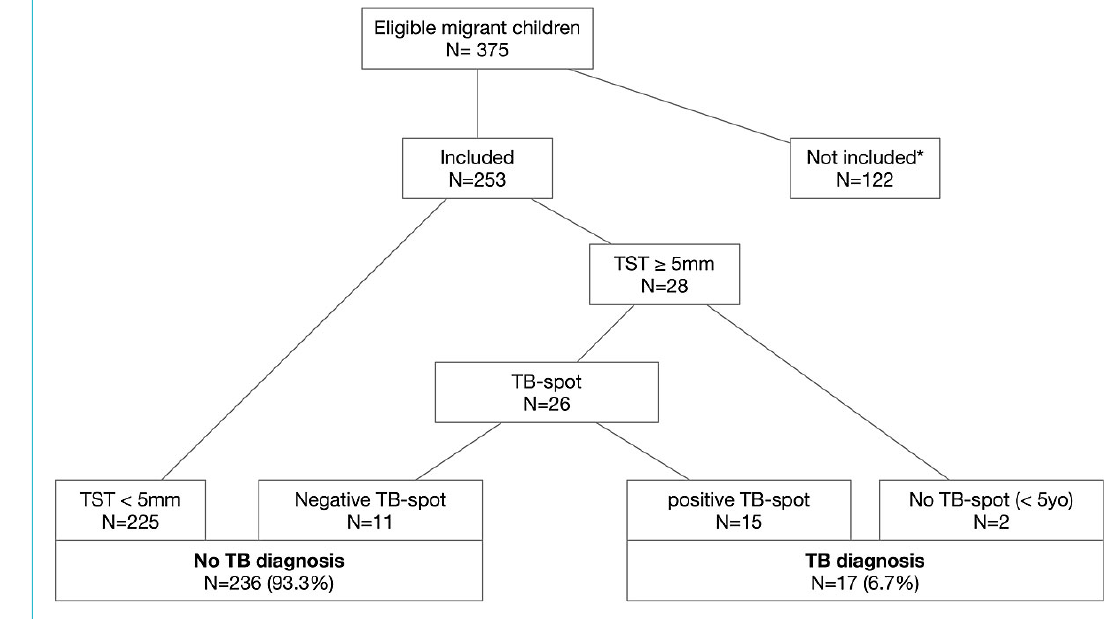
Figure 1: Description of the population. TB = tuberculosis; TBD = tuberculosis disease; TST = tuberculin skin test; * no TB screening (n = 16), parental refusal (n = 4), tuberculosis disease diagnosed before the assessment (n = 3), oblivion/lack of time (n = 87), lack of tuberculin skin test interpretation (n = 2), sold out of tuberculin skin tests (n = 9), screening before the medical assessment (n =